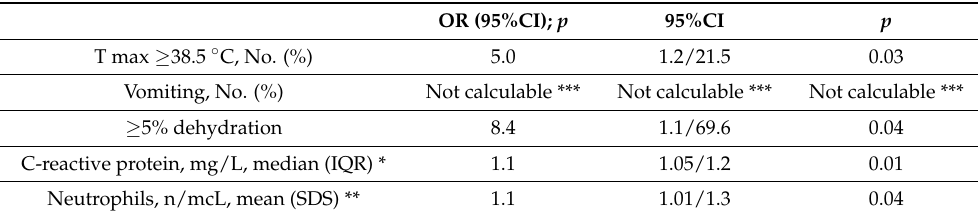
Table 2. Exploratory univariate logistic regression analysis exploring factors associated with AKI in children hospitalized for acute